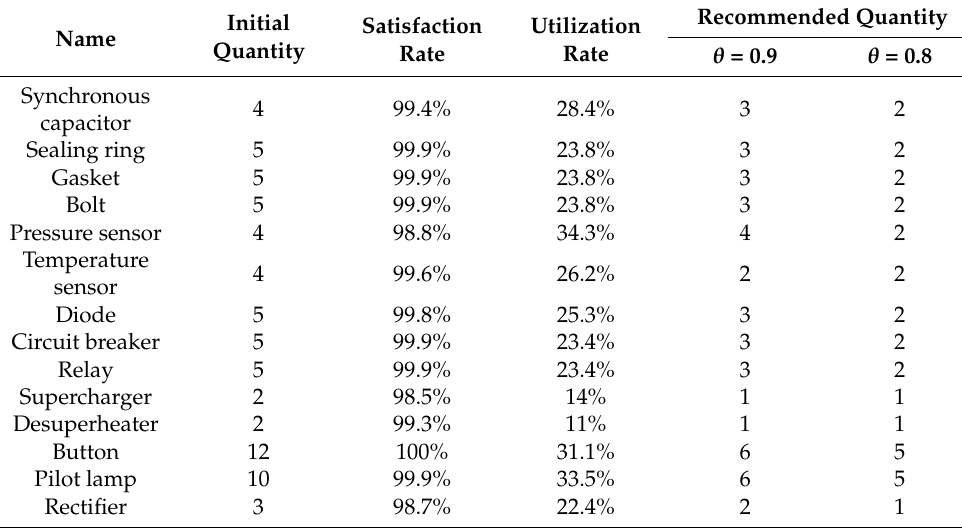
Table 7. The satisfaction rate and recommended quantity of support resource.